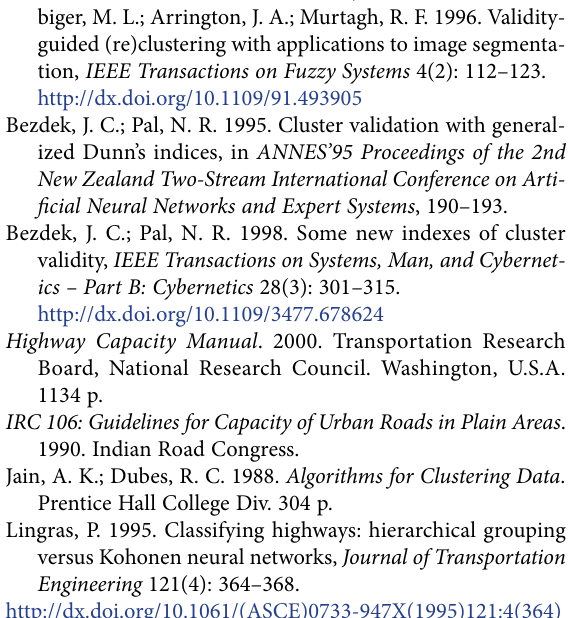
Manual (2000) is 40 to 55 km/hr, whereas, in Indian context this range is found to be 25 to 45 km/hr and 25 to 42 km/ hr using k -means and k -medoid clustering methods respectively. Speed ranges of the level of ser- vice categories found from using k -means and k -medoid methods are significantly different. Also, it was found that the urban street speed-ranges valid in Indian con- text are proportionately lower than the corresponding values mentioned in Highway Capacity Manual (2000). These lower values are highly heterogeneous traffic flow on urban roads with varying geometry. Average travel speed for each of the levels of service category expressed in terms of percentage of free flow speed is found to be different from those mentioned in Highway Capacity Manual (2000). Using validation parameter silhouettes a thorough investigation was carried out to find out the most suitable method, the one being applicable in In- dian context. Silhouette width and silhouette coefficient values found for urban street classes are having higher values for k -medoid clustering than k -means clustering; hence, k -medoid clustering method is more applicable in defining the level of service criteria in Indian context. Silhouette height of good quality of service categories ‘A’, ‘B’ and ‘C’ is less than those heights of poorer service categories like ‘D’, ‘E’ and ‘F’. This implies that probe ve- hicles traveled more frequently at poor service quality on urban streets in the present